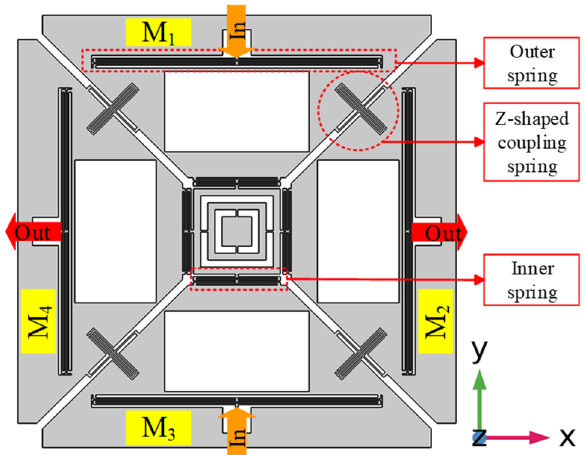
Figure 1. 2D Layout of the Designed Microelectromechanical systems (MEMS) Gyroscope.